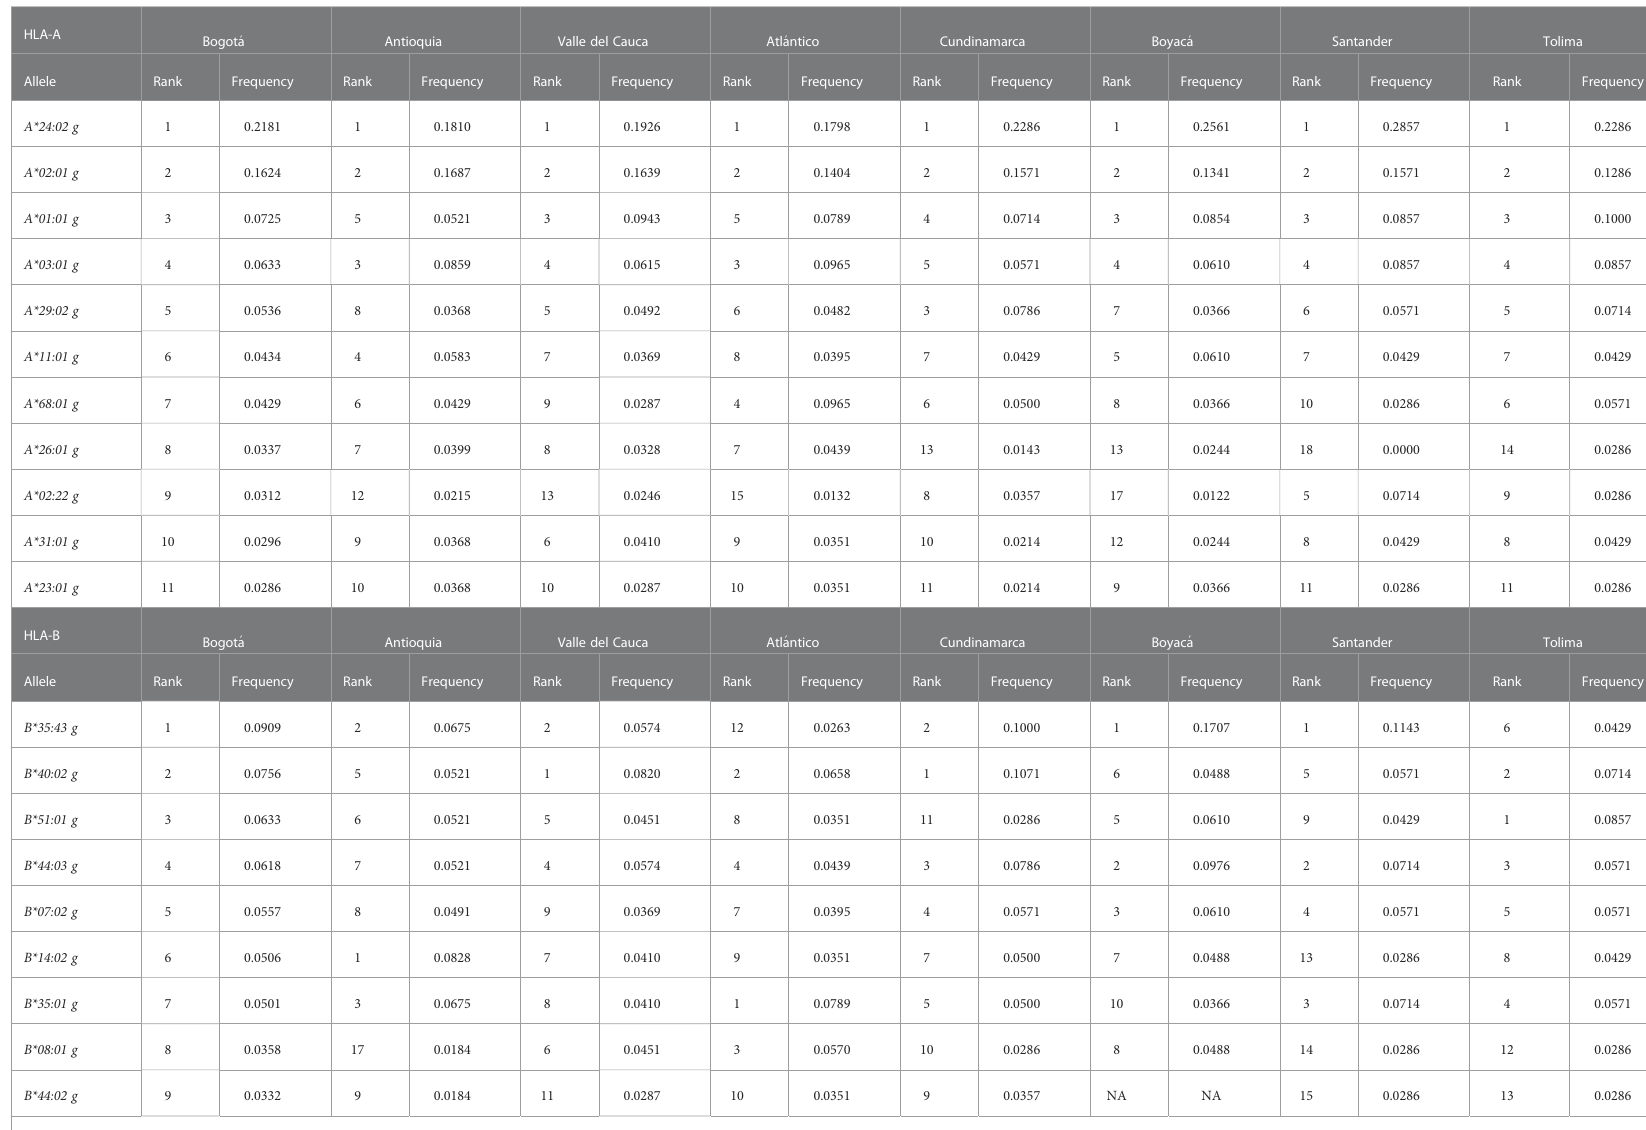
TABLE 8 The 11 most frequent HLA-A, HLA-B, HLA-C, HLA-DRB1, and HLA-DQB1 alleles in the city of Bogota ́ and the rank that these alleles occupied in the departments of Antioquia, Valle del Cauca, Atla ́ ntico, Cundinamarca, Boyaca ́ , Santander and Tolima.